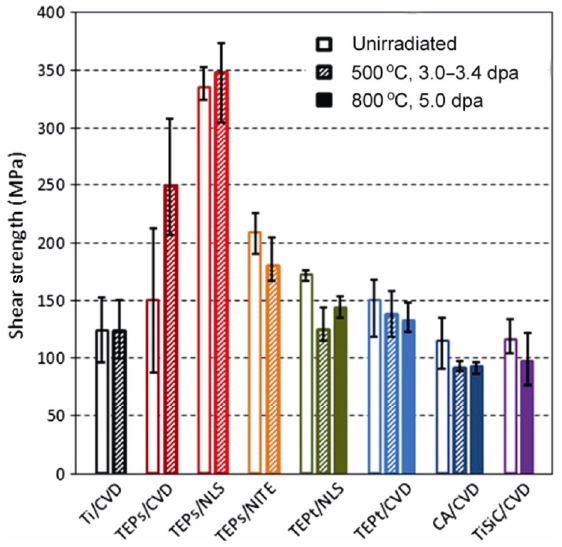
Fig. 11 Torsion shear strength of multiple joints before and after neutron radiation. The Ti, TEPs, TEPt, CA, and TiSiC denote the joining processes using Ti, SiC+Y 2 O 3 – Al 2 O 3 –SiO 2 , SiC+Y 2 O 3 –Al 2 O 3 , CaO–Al 2 O 3 , and Ti 3 SiC 2 as interlayers, respectively. The CVD, NITE, and NLS denote the CVD-SiC, SiC f /SiC composite fabricated by NITE process and NITE-like sintered SiC, respectively. Reproduced with permission from Ref. [12], © Elsevier B.V.